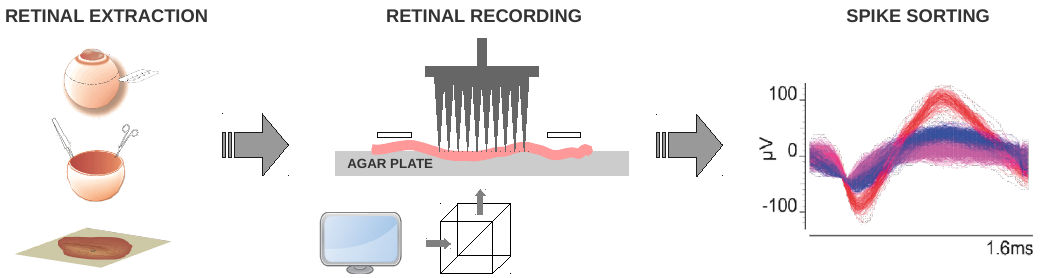
Figure 5. Data acquisition procedure of multi-electrode recordings and spike